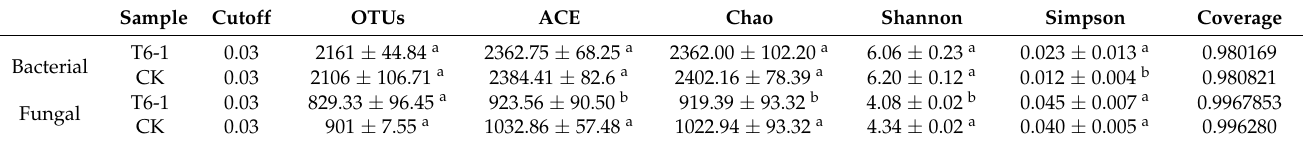
Table 4. Diversity along with richness indices of bacterial, as well as fungal communities from the two soil treatments.